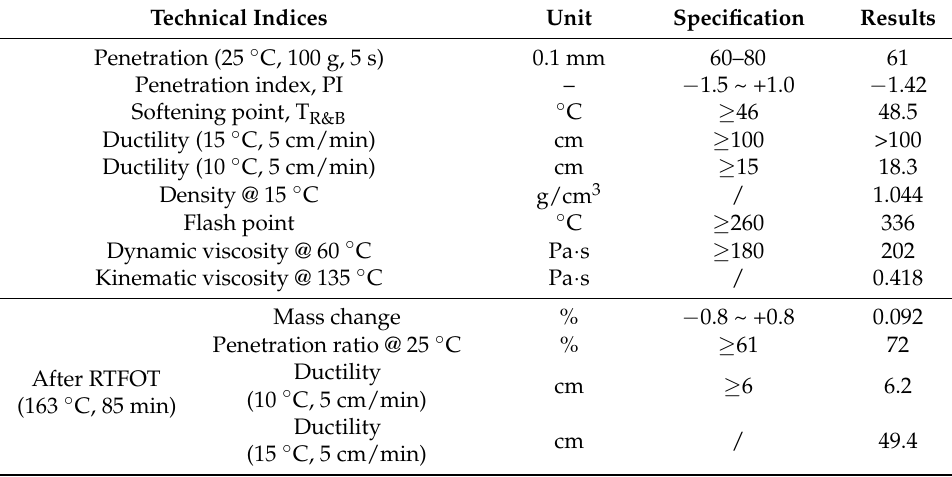
Table 1. Technical indices of AH-70 petroleum asphalt binder.